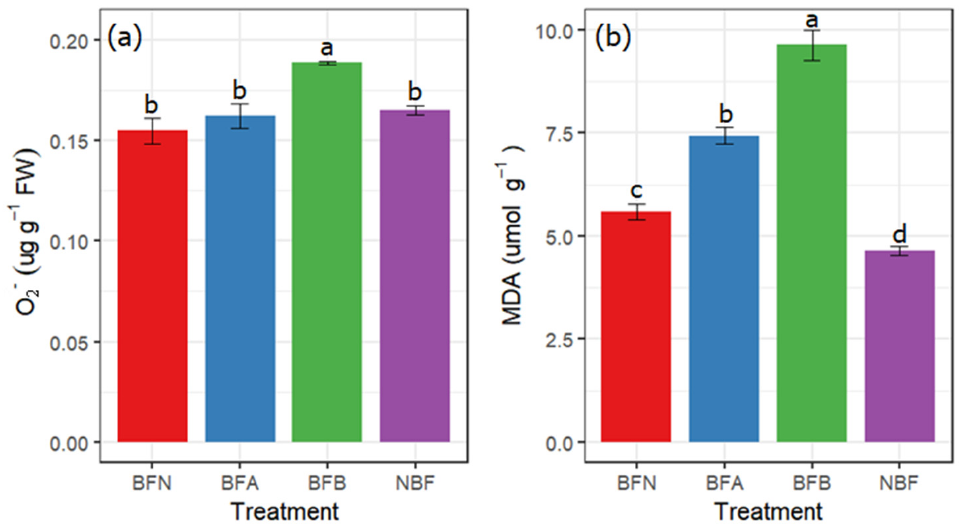
Figure 3. Effects of sunburn on membrane lipid peroxidation. ( a ) Superoxide anion content (O 2 − ), and ( b ) malondialdehyde content (MDA). Vertical bars are the mean ± SE ( n = 3). Different letters above the bars indicate significant differences at the 0.05 level by Duncan’s multiple range test.